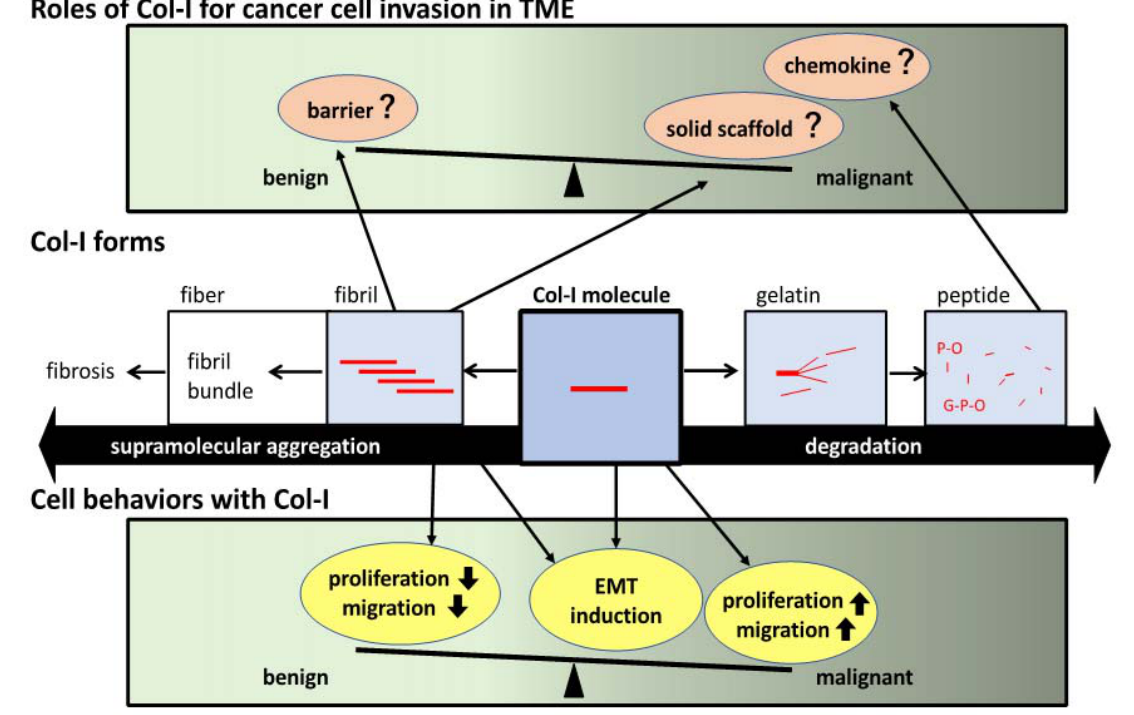
Figure 1. Schematic view of the roles of Col-I in cell invasion in TME. The middle row describes the type I collagen (Col-I) multiple forms. The ( top row , bottom row ) indicate the roles of Col-I in cancer cell invasion in tumor microenvironment (TME) and Col-I-influenced cell behaviors, respectively. Col-I molecules form supramolecular aggregates such as fibrils and fibers, or conversely, it forms gelatin upon denaturation. Gelatin is further degraded to peptides, which act as soluble factors ( middle row ). These variations in the Col-I form have distinct effects on cell behavior. In general, Col-I in the supramolecular aggregation state suppresses cell proliferation and migration, thereby inhibiting the malignant transformation of cancer, whereas Col-I molecules promote proliferation and migration, thereby promoting malignant transformation. In both conditions, EMT is induced ( bottom row ). It is said that Col-I, in its supramolecular aggregation state, exhibits contradictory functions: one is to act as a physical barrier against cancer and inflammatory cells, whereas the other is to provide a solid scaffold that promotes cancer cell invasion. Col-I peptides can act as chemotactic agents and may promote malignant transformation ( top row